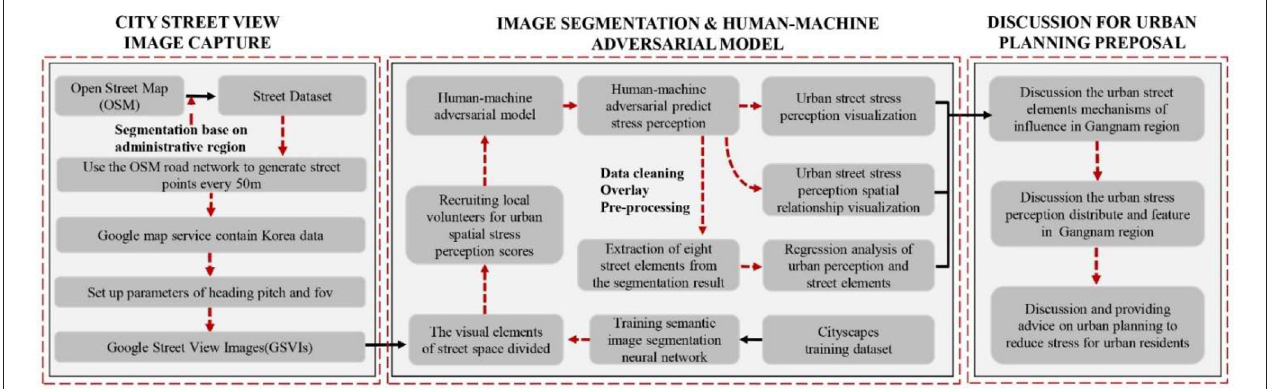
FIGURE 1 | Analytical framework for the measurement of perceived stress in an urban built